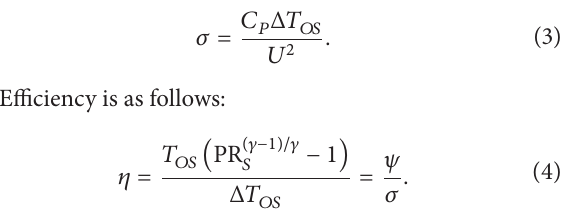
Figure 1: The diagram of sectionalized axial flow